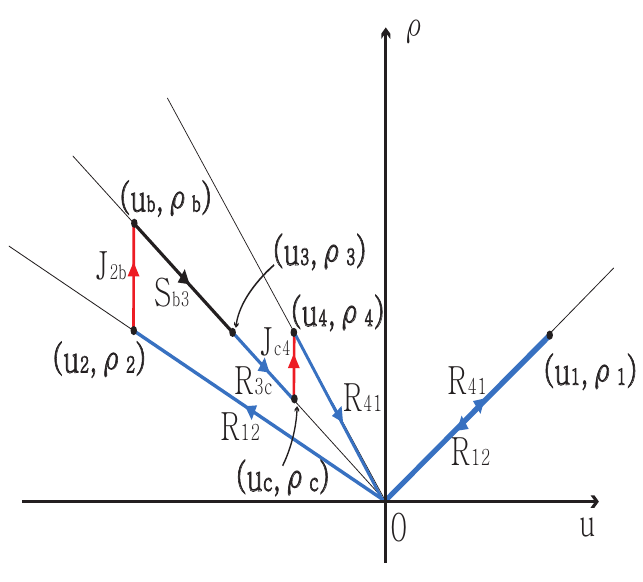
Figure 1. Wave curves in phase plane for u 2 < u 3 < u 4 < 0 < u 1 .